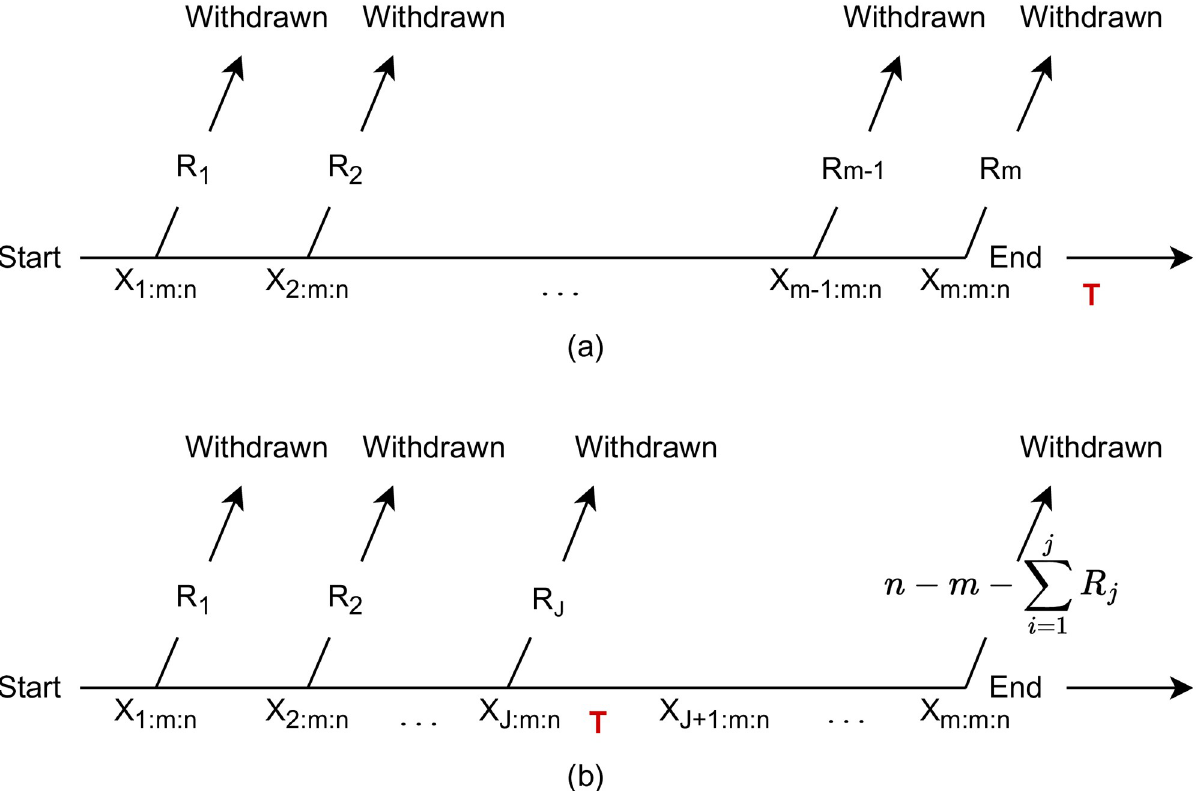
Fig 1. Adaptive type-II progressive hybrid censoring model as proposed by Ng et al., (2009). (a) Experiment ends before time T. (b) Experiment ends after time T.